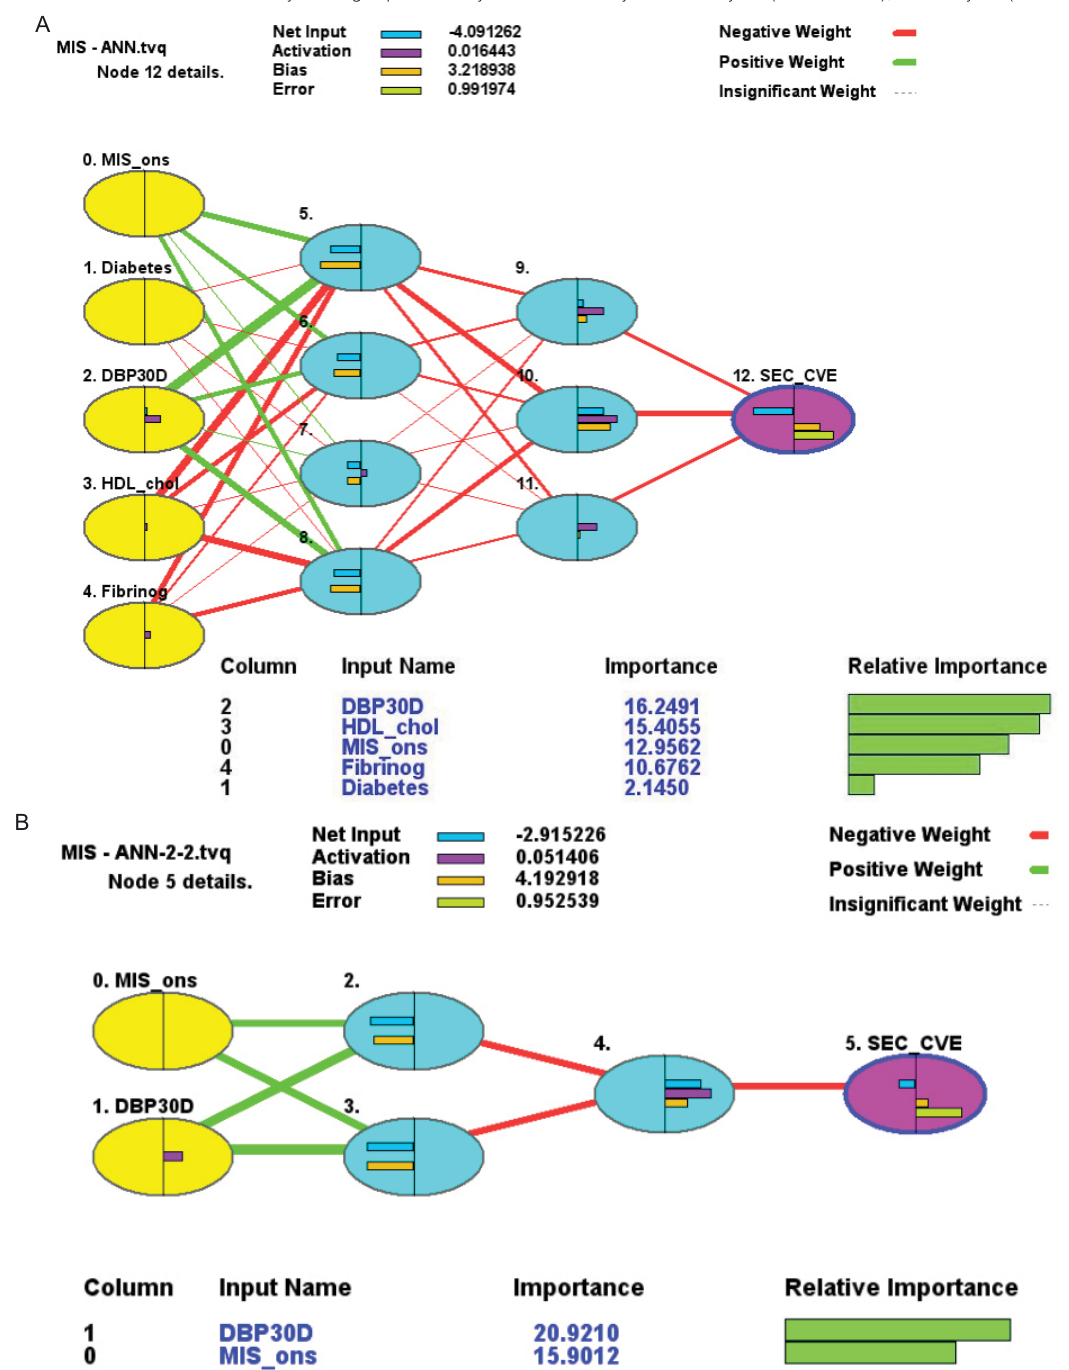
Figure 2. Artificial neural network trained with 54 patients to order the risk factors by their relative importance to CV event occurrence. A) Yellow circles (No. 0–4) on the left indicate 5 input variables. The magenta circle (No.12) on the right is the output variable. The nodes of two hidden layers are grouped vertically and coloured in cyan: hidden layer 1 (nodes No.5–8); hidden layer 2 (nodes No.9–11); B) Yellow circles (No. 0–1) on the left indicate 2 input variables. The magenta circle (No.5) on the right is the output variable. The nodes of the two hidden layers are grouped vertically and coloured in cyan: hidden layer 1 (nodes No.2–3); hidden layer 2 (node